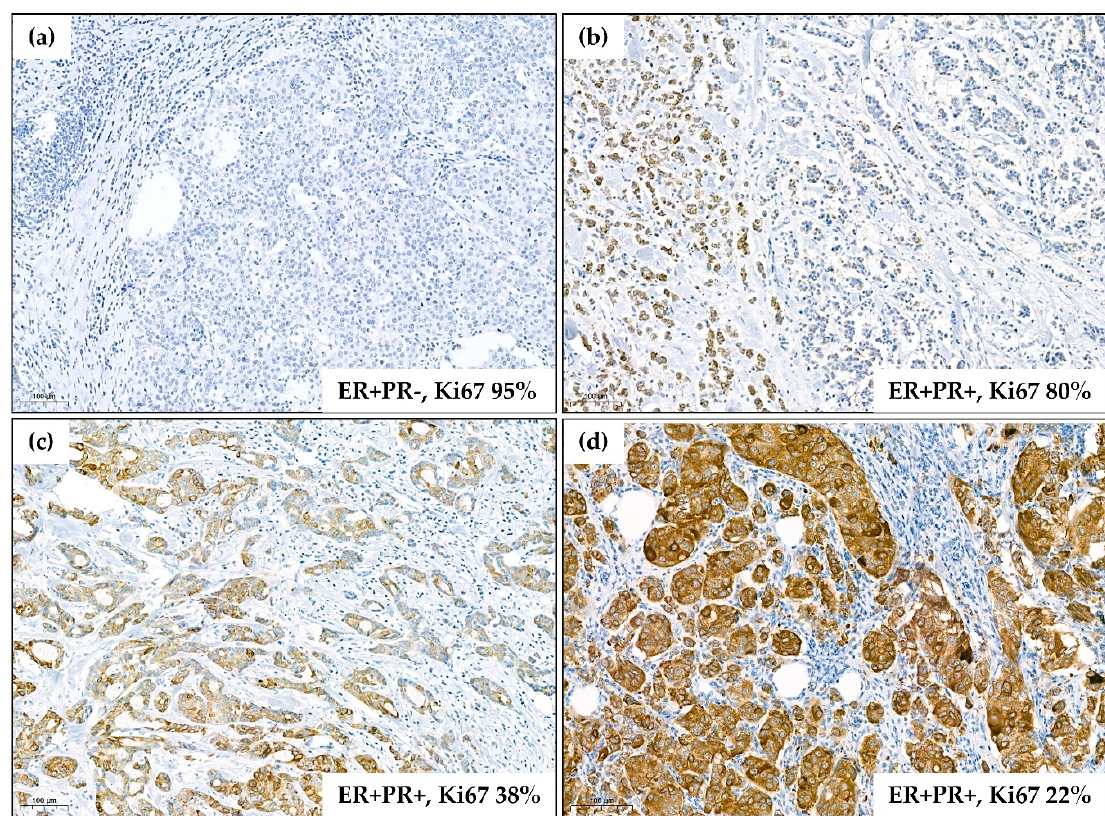
Figure 2. Representative images of immunohistostaining for FGFR2 using H00002263-M01 antibody (Abnova). Corresponding data on hormonal receptor status and Ki67 proliferation index are presented for each tumor. The images are representative for the main observations on the links between FGFR2 levels and clinicopathological features (low levels of FGFR2 associated with ER/PR negativity and high Ki67 index). ( a ) Negativity of cancer cells for FGFR2 (0/3 in semiquantitative scale with H-score of 0/300); ( b ) weak positivity for FGFR2 (1/3 in semiquantitative scale with H-score of 80 (5 × 3 + 30 × 2 + 5 × 1 + 60 × 0)); ( c ) moderate positivity for FGFR2 (2/3 in semiquantitative scale with H-score of 170 (20 × 3 + 35 × 2 + 40 × 1 + 5 × 0)); ( d ) very strong positivity for FGFR2 (3/3 in semiquantitative scale with H-score of 290 (90 × 3 + 10 × 2)). Scale bars indicating 100 µm are applied on each image.